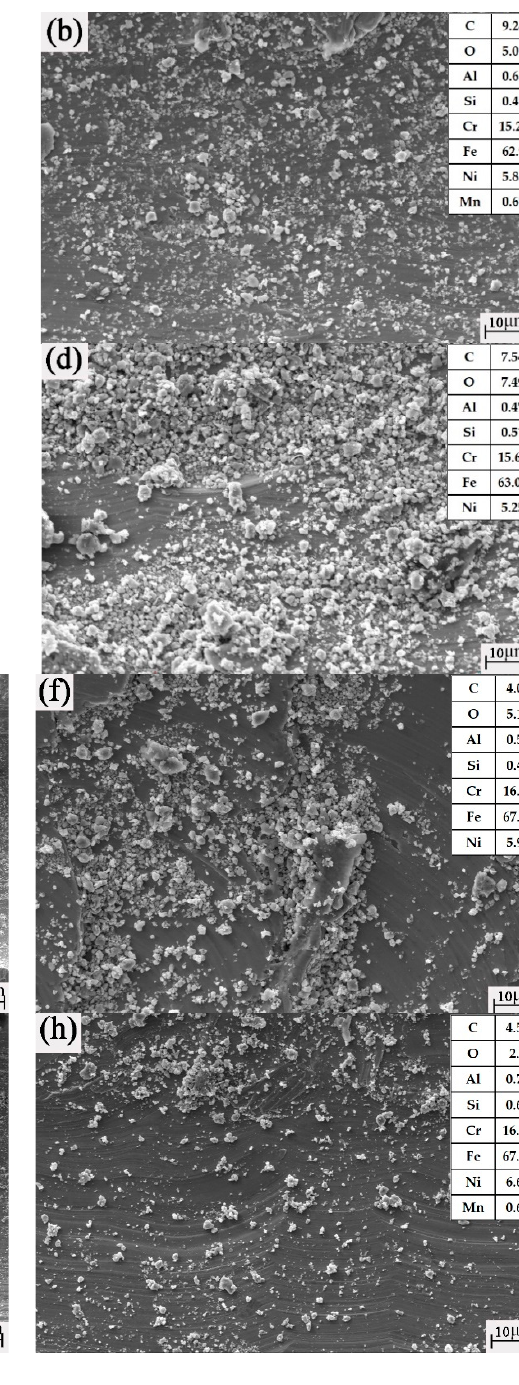
Figure 7. SEM images of the groove-textured worn plates: ( a , b ) 0.4 mm groove width mechanical texture rotation radius 18 mm, ( c , d ) 0.6 mm groove width mechanical texture rotation radius 18 mm, ( e , f ) 0.8 mm groove width mechanical texture rotation radius 18 mm, and ( g , h ) 1.0 mm groove width mechanical texture rotation radius 18 mm.